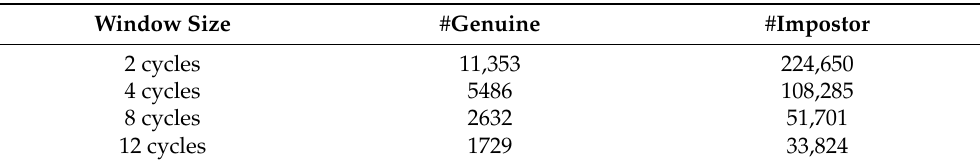
Table 2. Test set sizes for the different window sizes tested. Columns #Genuine and #Impostor show the number of genuine and impostor test trials,